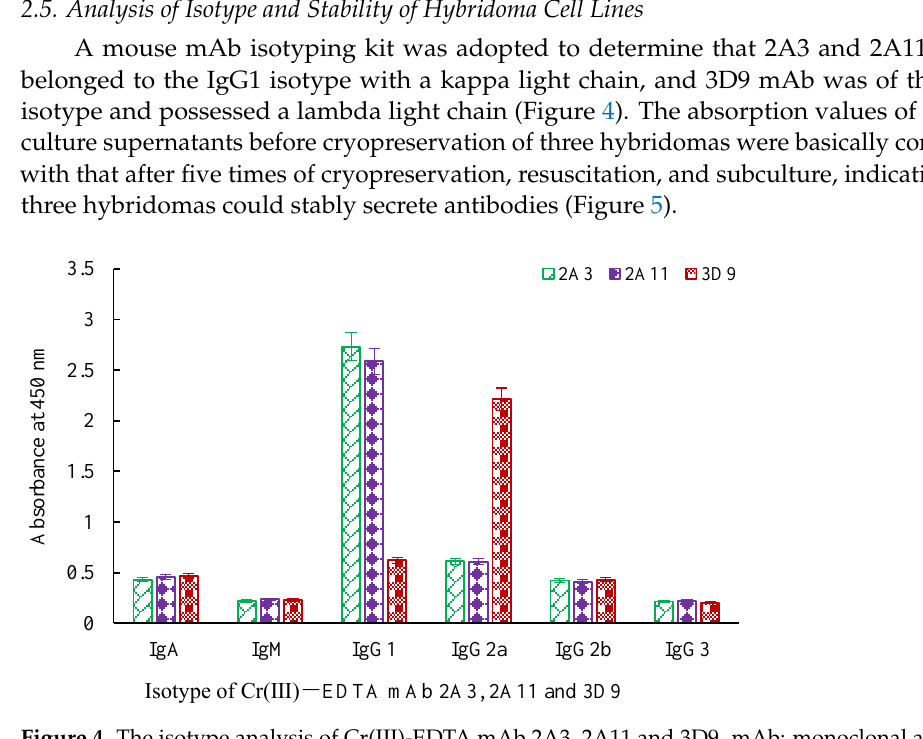
Figure 4. The isotype analysis of Cr(III)-EDTA mAb 2A3, 2A11 and 3D9. mAb: monoclonal antibody.